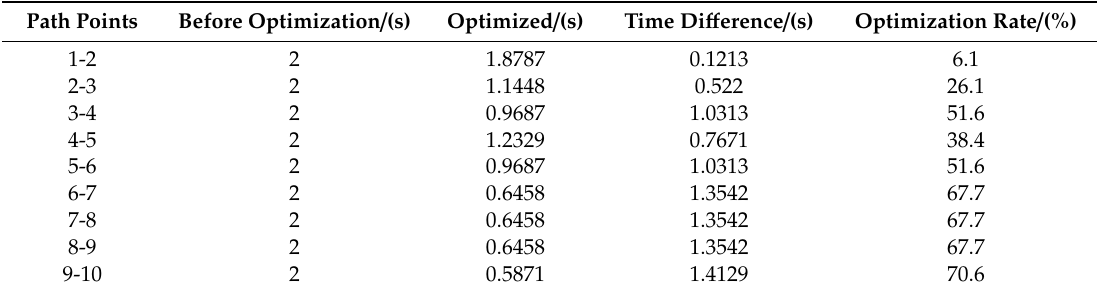
Table 7. Comparison of time optimization results in the obstacle environment.